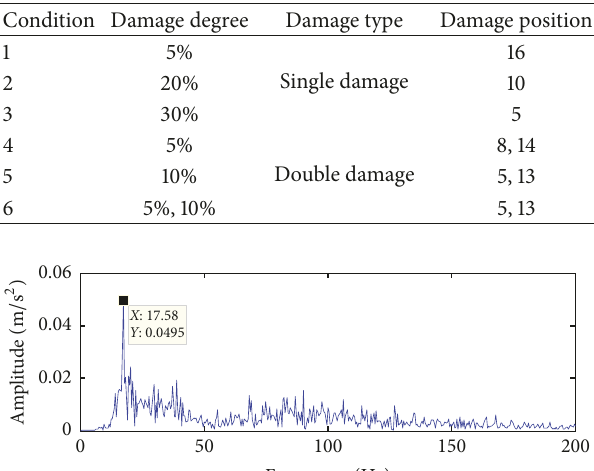
Table 1: Damage condition of the derrick steel structure.